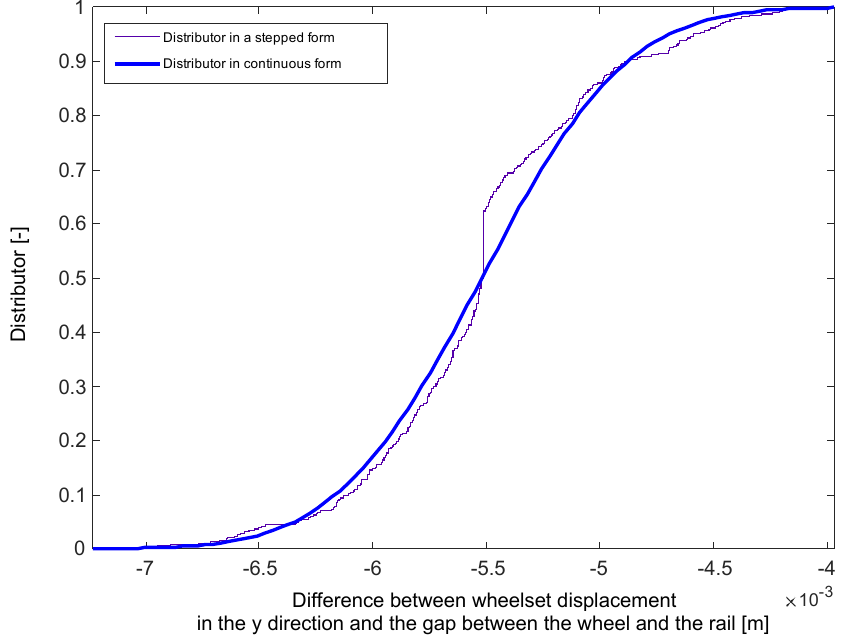
Figure 16. Distribution function for the difference between displacement and a gap for a train crossing the turnout along a straight track with a speed of v = 200 km/h. Identical simulations were performed for the speeds of 250 km/h, 300 km/h and 350 km/h.